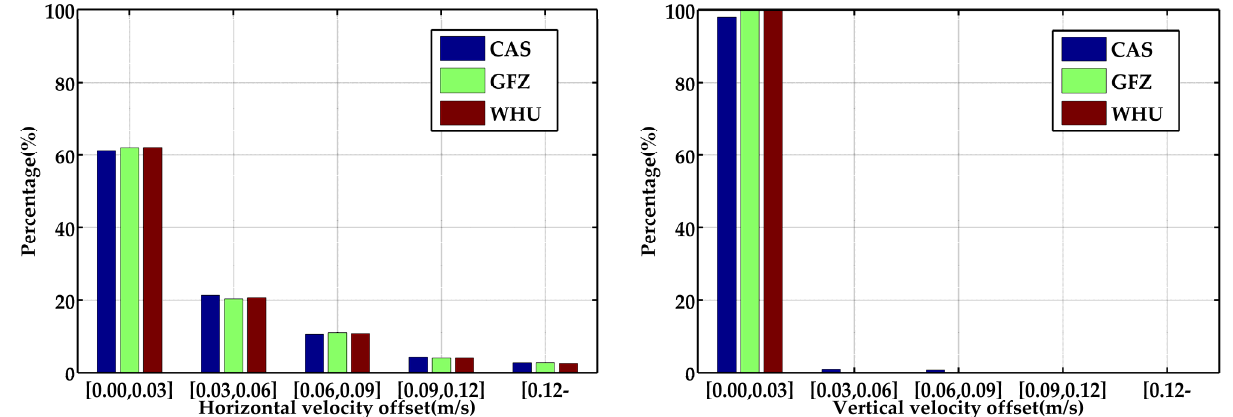
Figure 13. Distribution of velocity offsets in horizontal ( left ) and vertical ( right ) directions of G + B SF-PPP/INS tight integration using the real-time products from CAS, GFZ, and WHU.